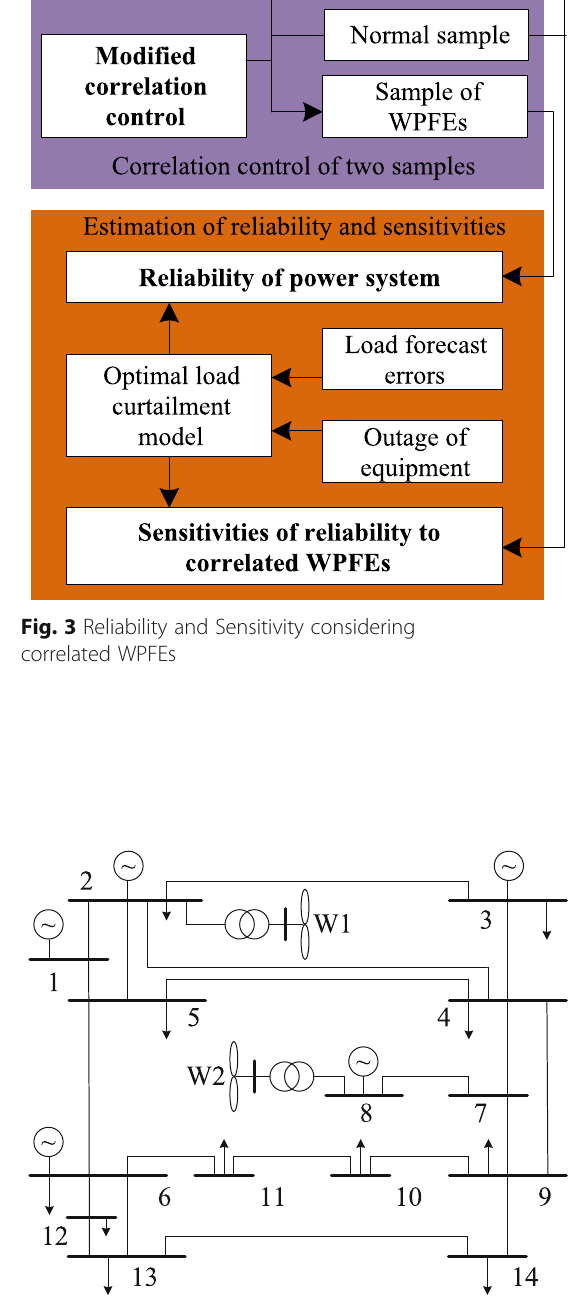
Fig. 4 Modified IEEE 14-bus test